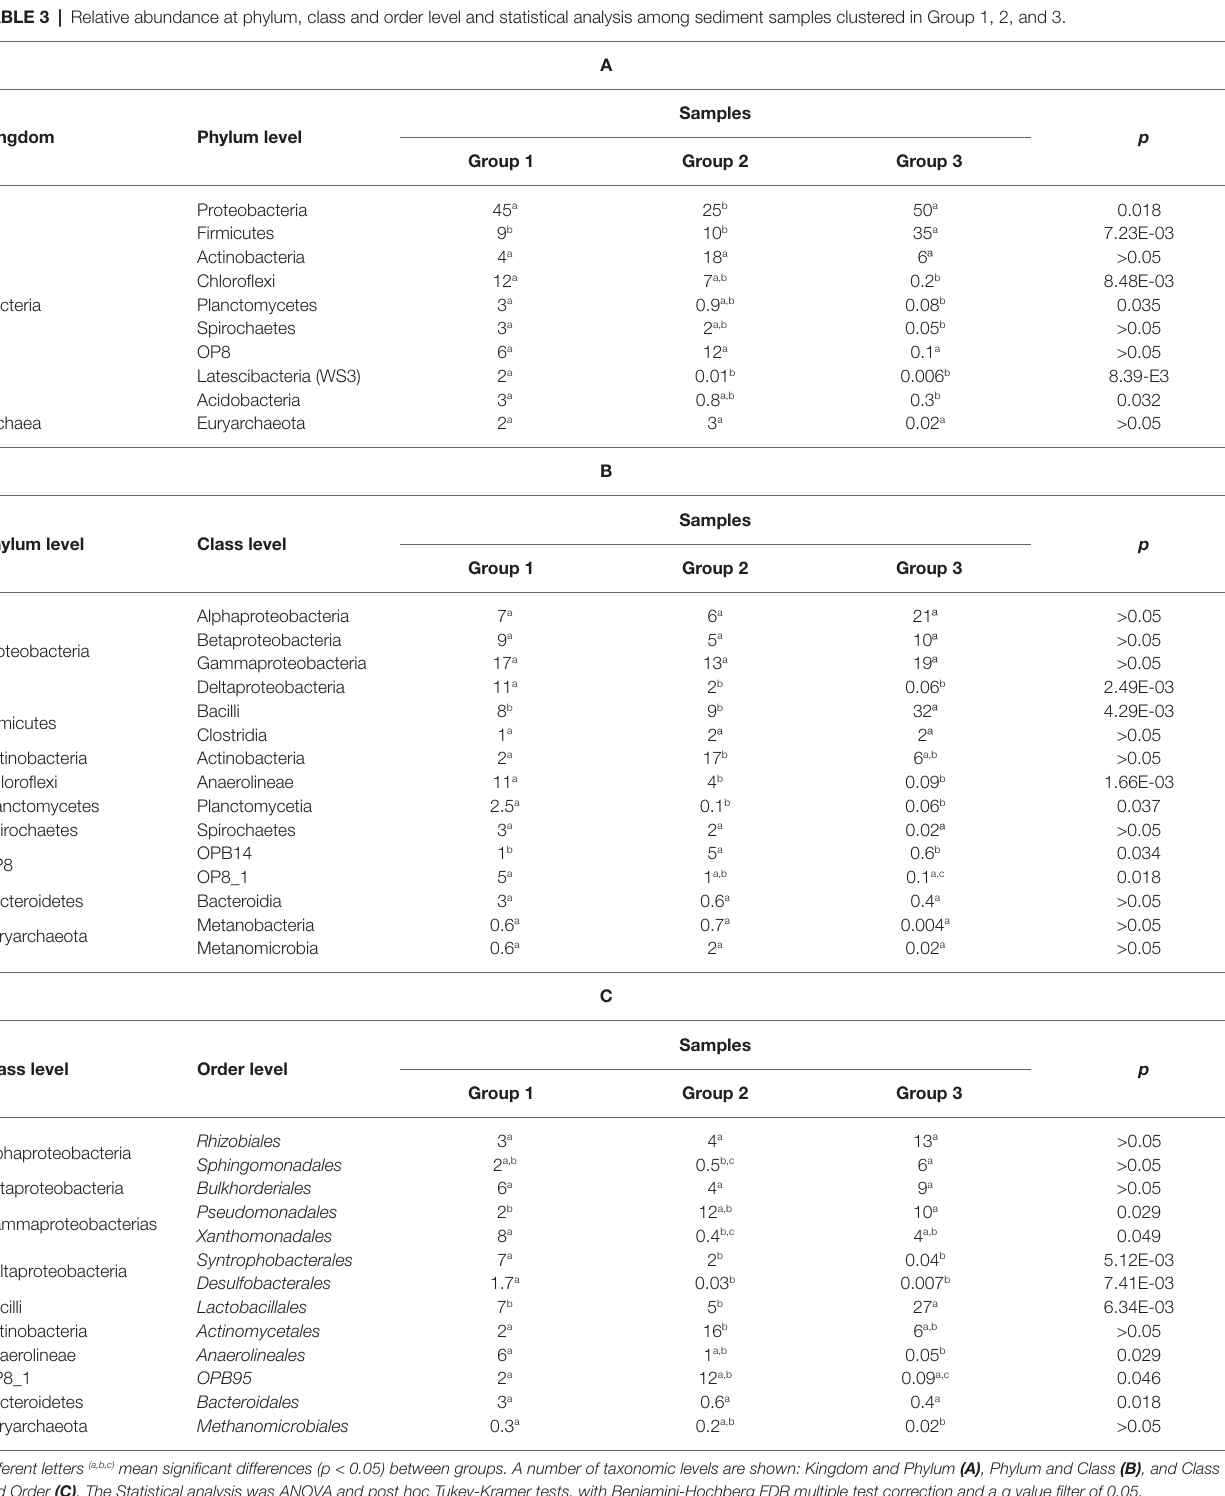
TABLE 3 | Relative abundance at phylum, class and order level and statistical analysis among sediment samples clustered in Group 1, 2, and